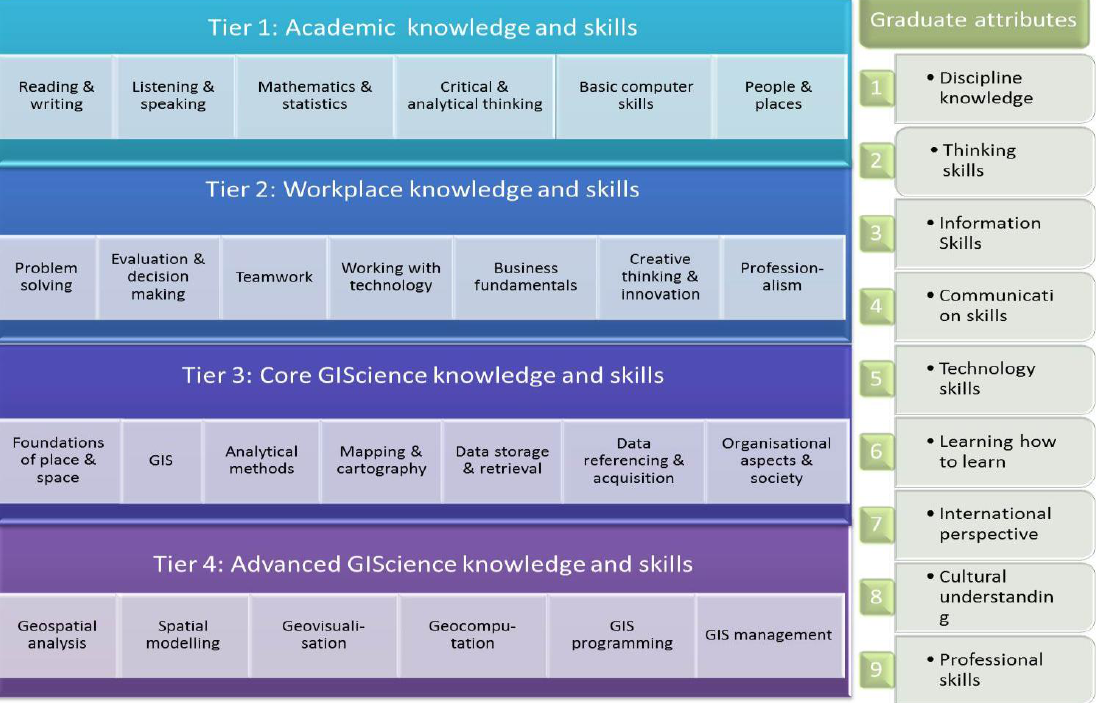
Figure 3: GIScience higher education curriculum